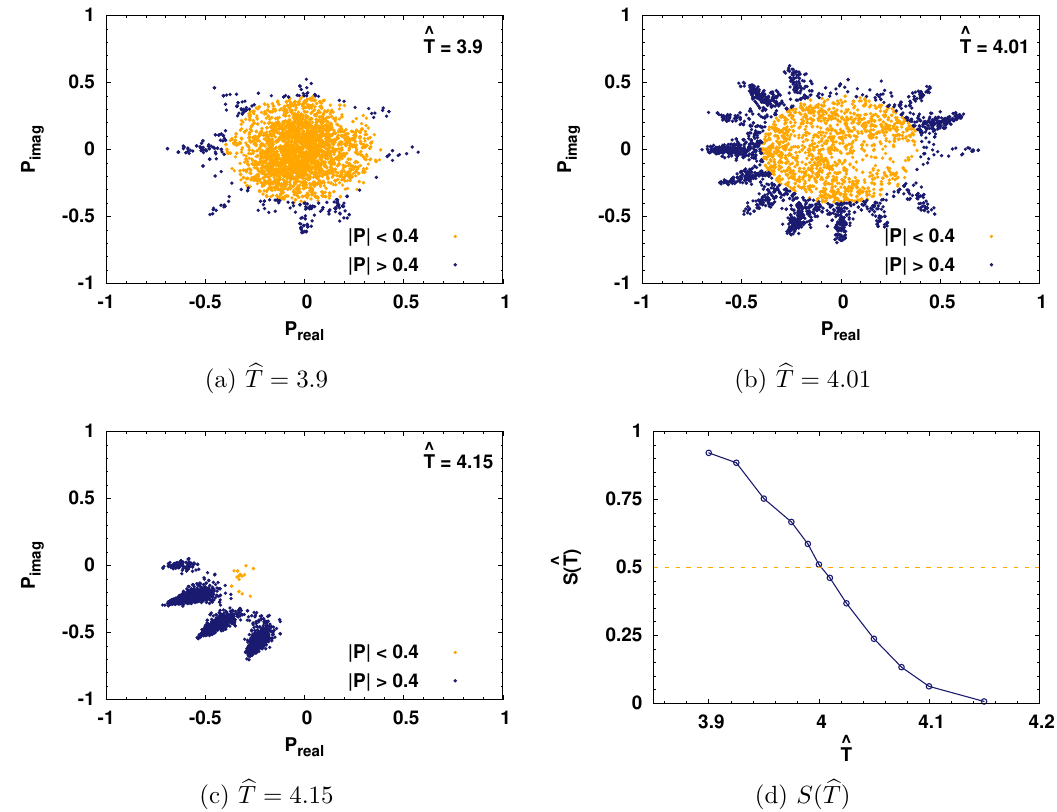
Figure 4. Polyakov loop scatter plots for N = 16 with same r = 0 . 4 circular separatrix as figure 3. The resulting S ( b T ) in panel (d) identifies the critical S temperature b T 4 c ≈